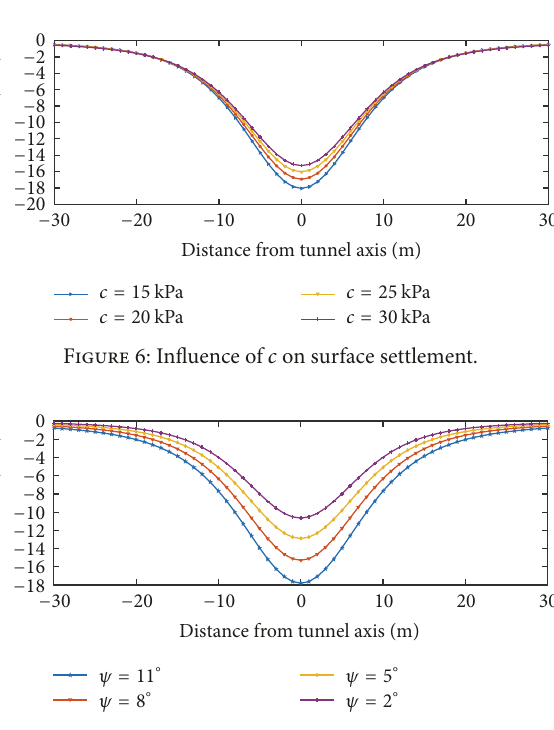
Figure 7: Influence of 𝜓 on surface